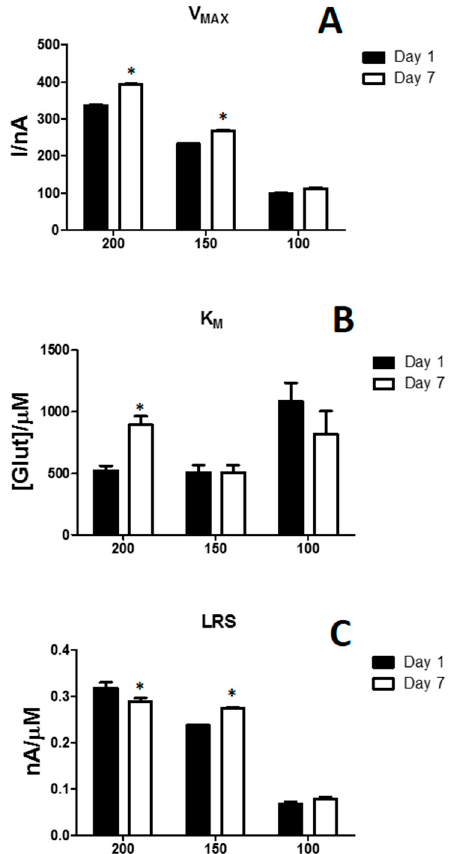
Figure 3. Bar chart showing the modifications of V MAX (Panel A), K M (Panel B) and LRS (Panel C) on biosensor designs loading different enzyme concentrations (200 U/mL, 150 U/mL and 100 U/mL) at Day 1 (black bars) and Day 7 (withe bars). Values are expressed as mean ± SEM. * p < 0.05 vs. Day 1.